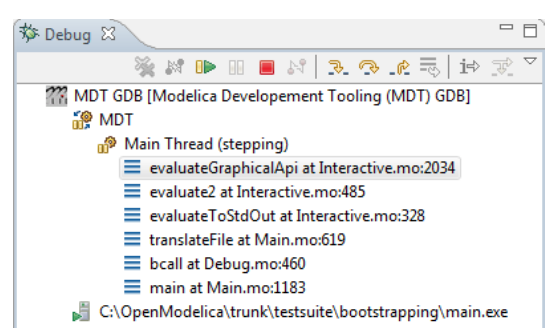
Figure 4: The stack frame view of the debugger.